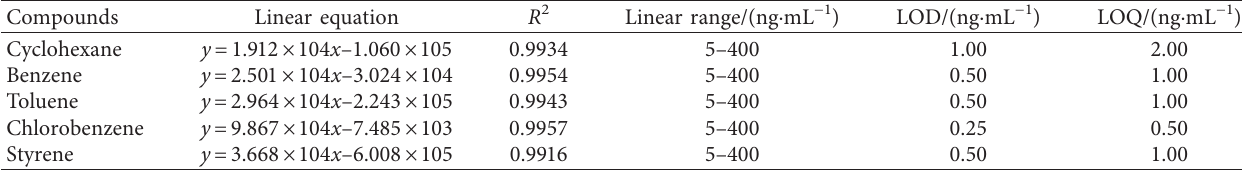
Table 2: Linear range and sensitivity of five volatile organic compounds.